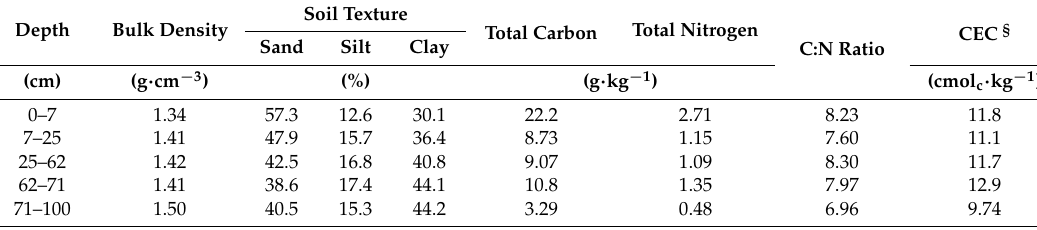
Table 1. Physical and chemical characteristics of soil in a citrus orchard field in southwestern Japan.